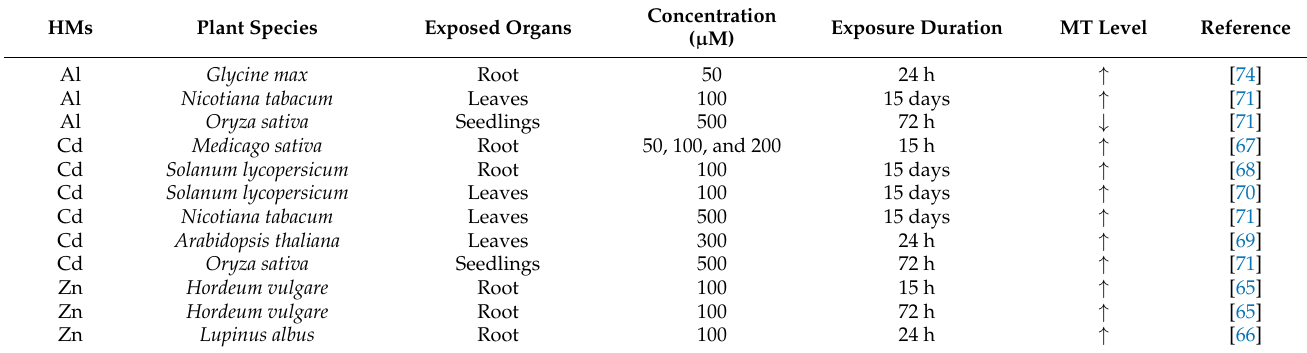
Table 1. Effects of HMs on the levels of endogenous melatonin accumulation in